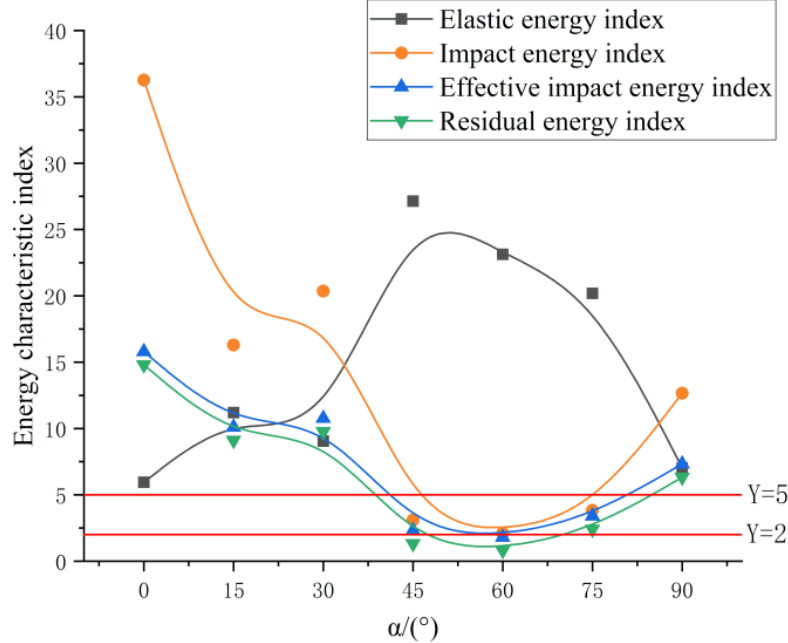
Figure 10. Characteristic energy index of coal at different azimuth angles.